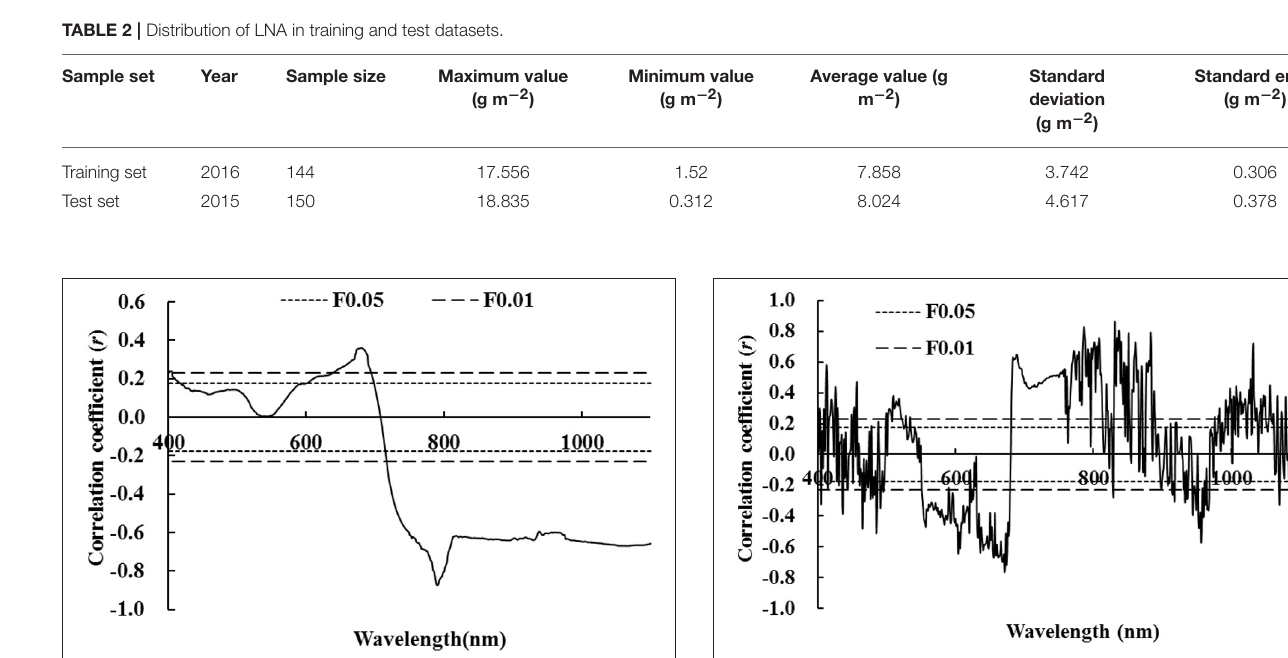
FIGURE 2 | Correlation coefficient between first-order hyperspectral reflectance and wheat LNA (The correlation coefficient outside the two P 0.05 lines was significant at 0.05 level, while the correlation coefficient outside the two P 0.01 lines was significant at 0.01